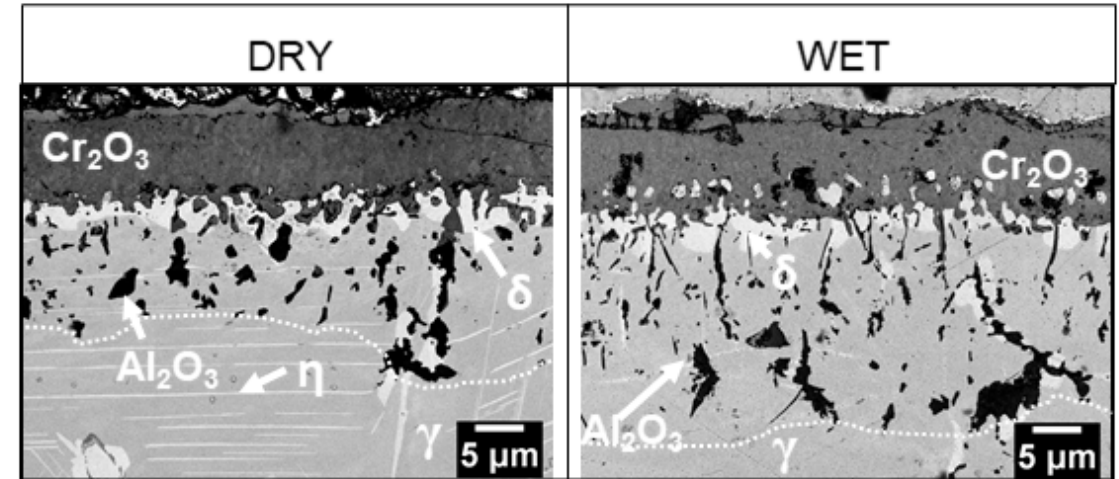
Figure 10. Cross-sectional microstructure of the 718Plus superalloy after oxidation at 850 °C for 4000 h in dry (left) and wet (right) air; SEM-BSE images.